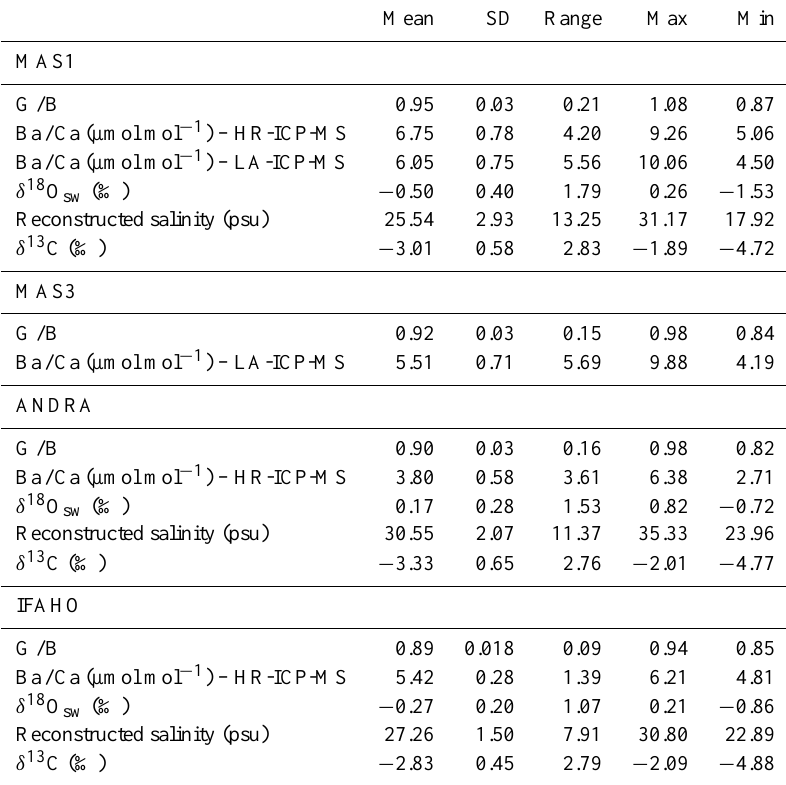
Table 3. Statistical description of coral proxy data for MAS1 (upper), MAS3 (middle upper), ANDRA (middle lower) and IFAHO (lower). The mean, standard deviation (SD), range, maximum value (Max) and minimum value (Min) were calculated from the monthly interpolated data spanning January 1991 till December 2005 (15yr). The proxy data include G/B, Ba/Ca (two methods), δ 18 O sw , δ 13 C and reconstructed salinity based on the δ 18 O sw (Fig.